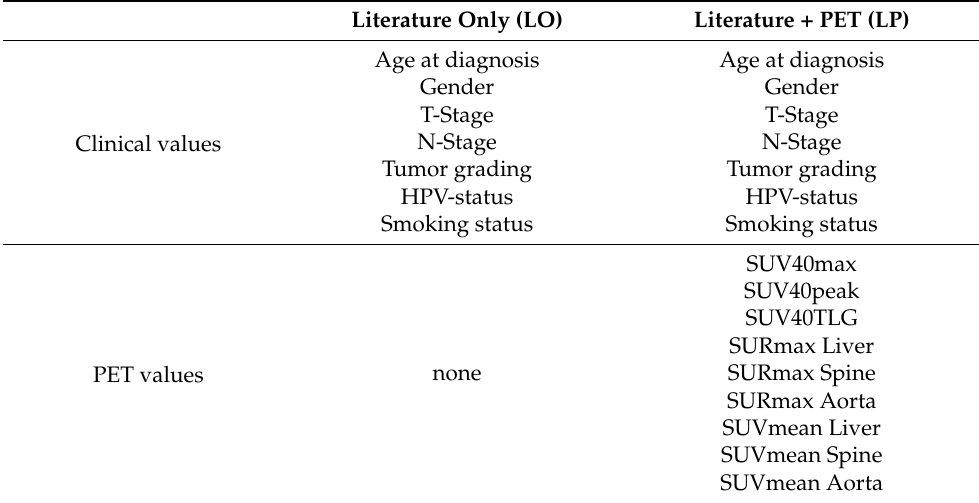
Table 1. Selected features for LO and